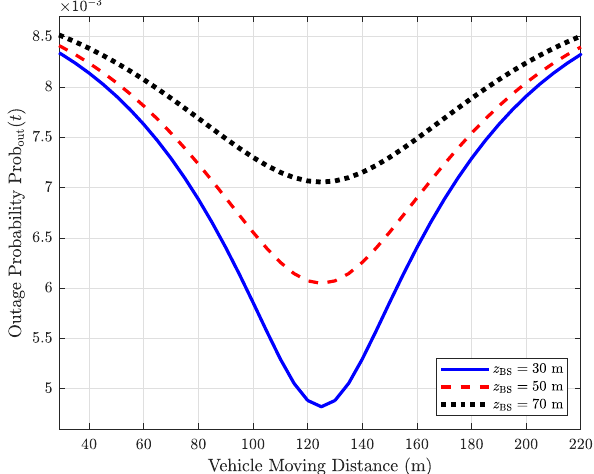
Figure 10. Outage probabilities for different positions of the